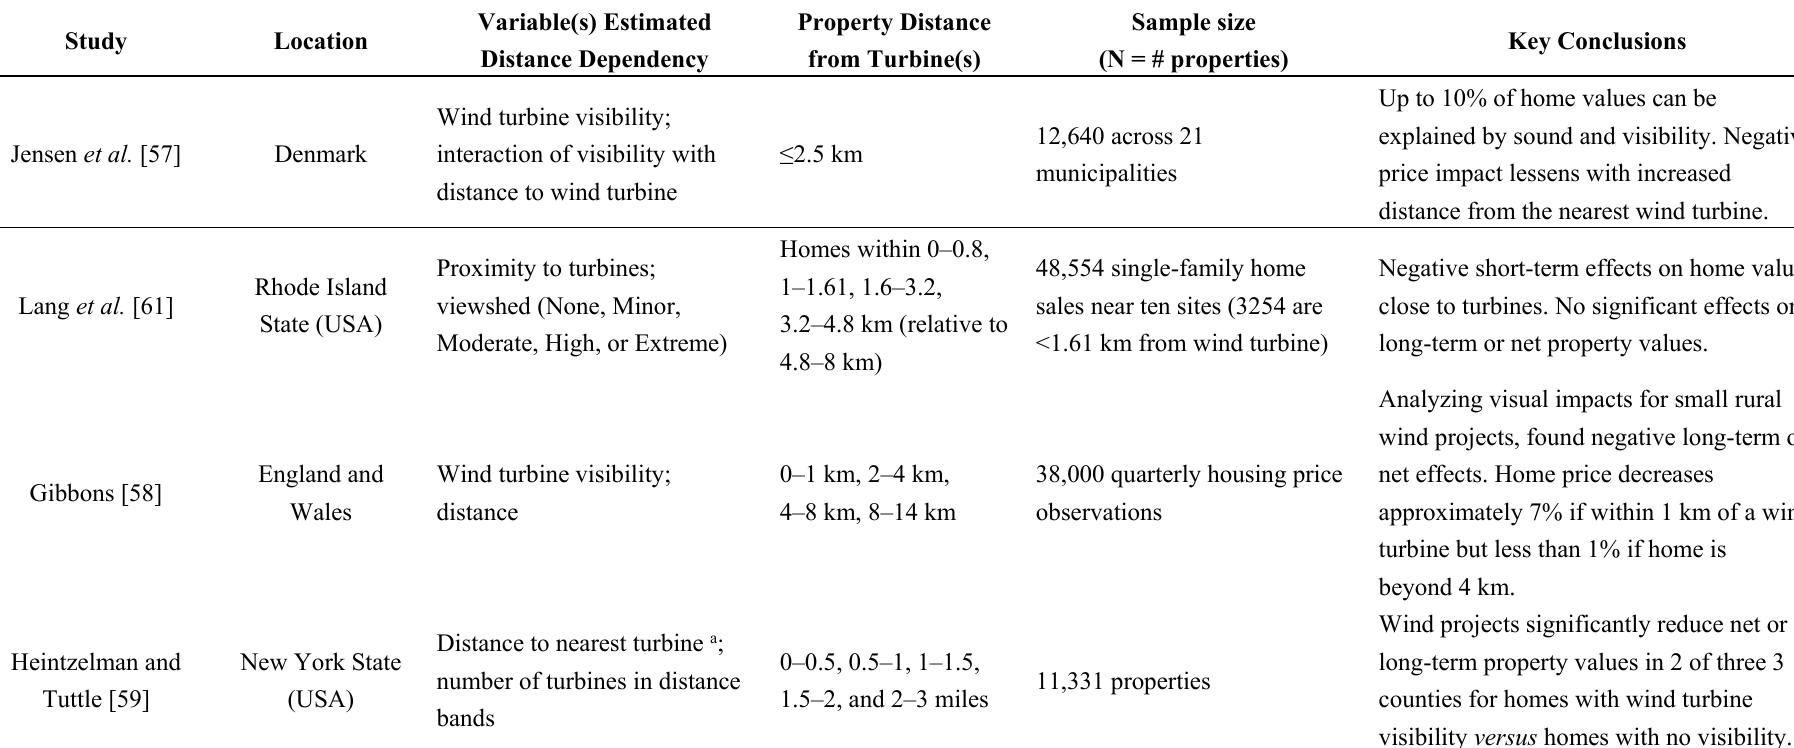
Table 2. Hedonic results estimating distance dependence of revealed preferences (RP) for onshore wind